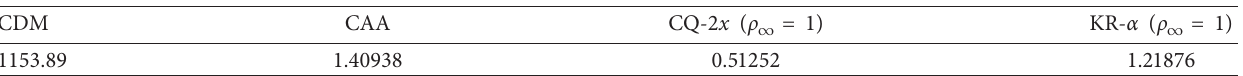
Table 6: Time consumption of the different algorithms for solving the beam with the moving spring mass in Example 4 (unit: second).